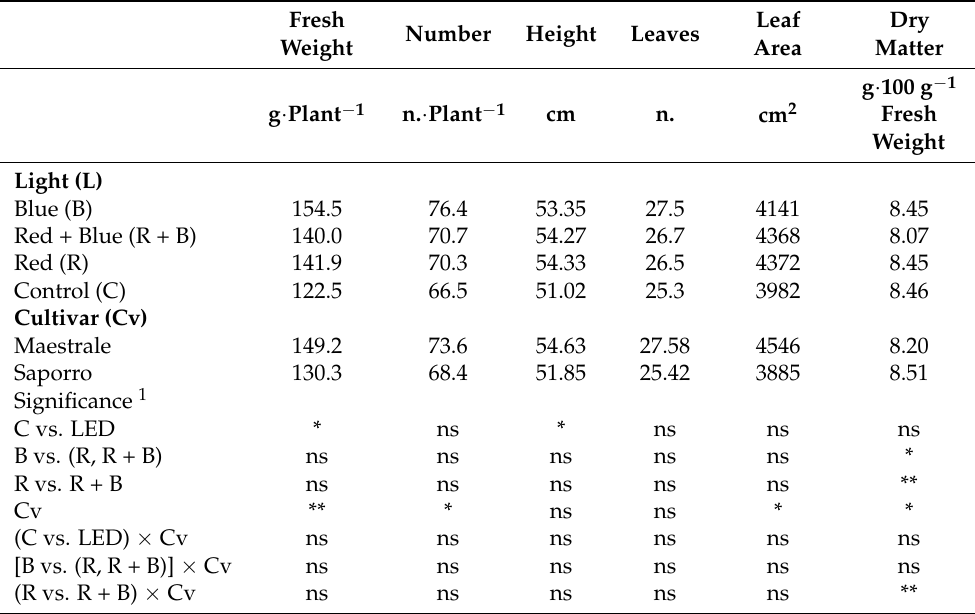
Table 1. Effects of light spectra and cultivar on fresh weight, number and dry matter percentage of pods, height, number of leaves, and leaf area of green